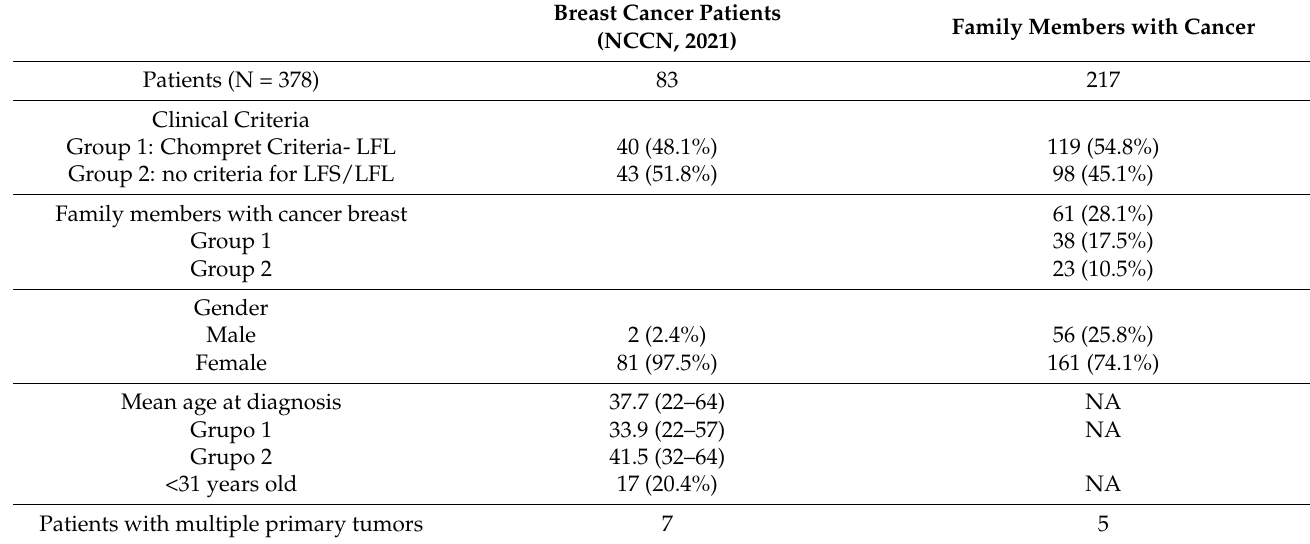
(Table 1). Table 1 summarizes the clinical features of our HBOC patients. Table 1. Clinical characterization of breast cancer patients and family history of